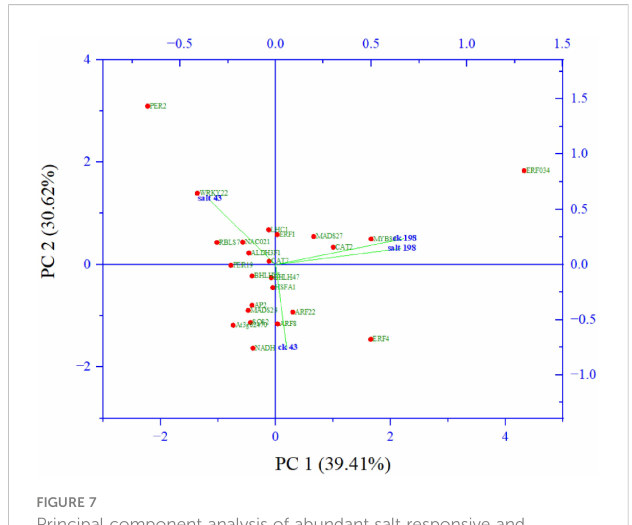
FIGURE 7 Principal component analysis of abundant salt responsive and photosynthesis target genes from gene